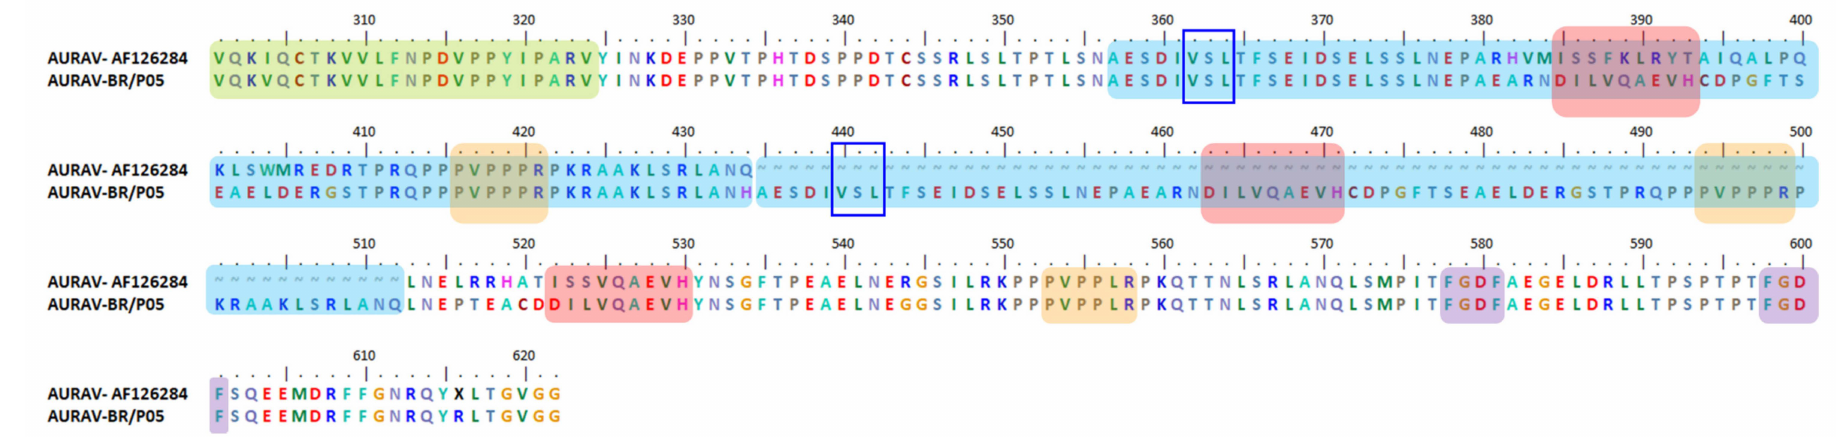
Figure 3. Important motifs and mutation events in AURAV nsP3 HVD. The HVD starts at position 325. It has two P-rich regions at positions 416–421 and 553–558 (peach) as well as two FGDF-like motifs at positions 578–581 and 598–601 (purple). There is a duplication motif for BR/P05 at position 435–512, with a motif sequence template from 357–434 (blue). There is also a repetitive motif, DILVQAEVH, at positions 385–393 and 522–530 as well as one duplication motif at position 463–471 (red). There is also a short motif, VSL, that is possibly conserved and duplicated among AURAV strains at positions 362–364 and 440–442 (blue